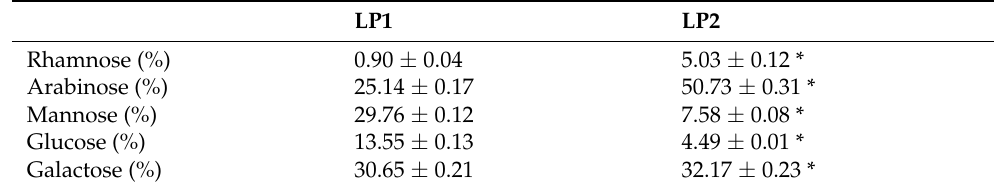
Table 2. The monosaccharide compositions of LP1 and